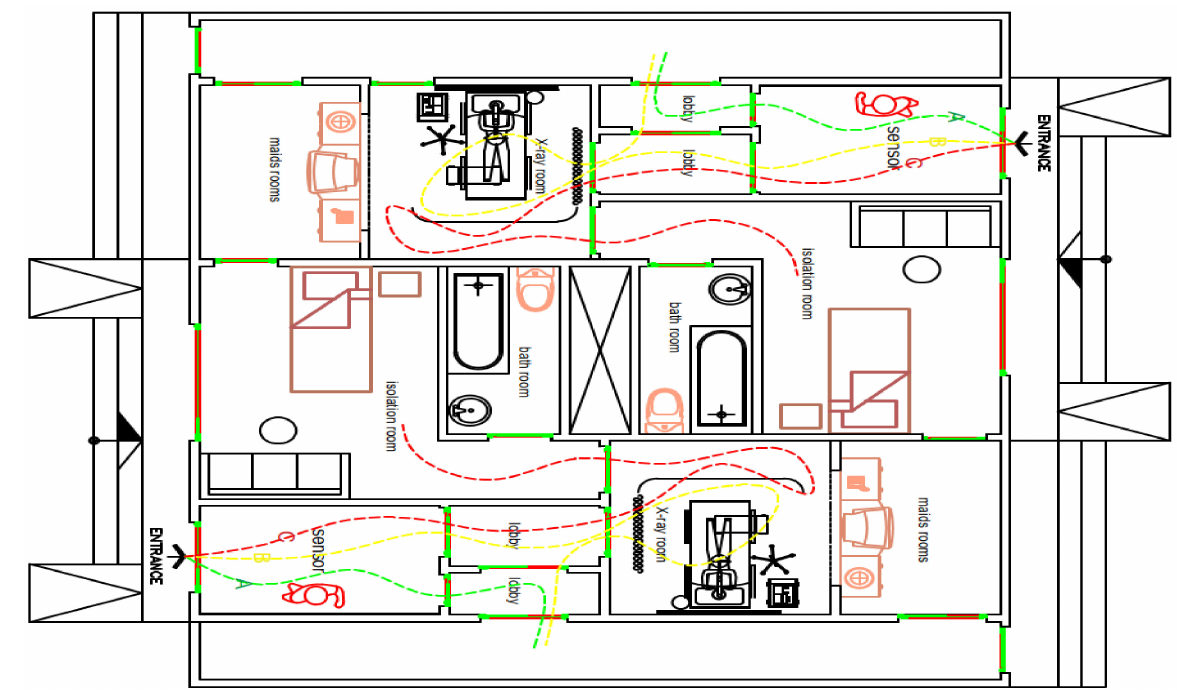
Figure 7. The plan of the proposed smart clinic.